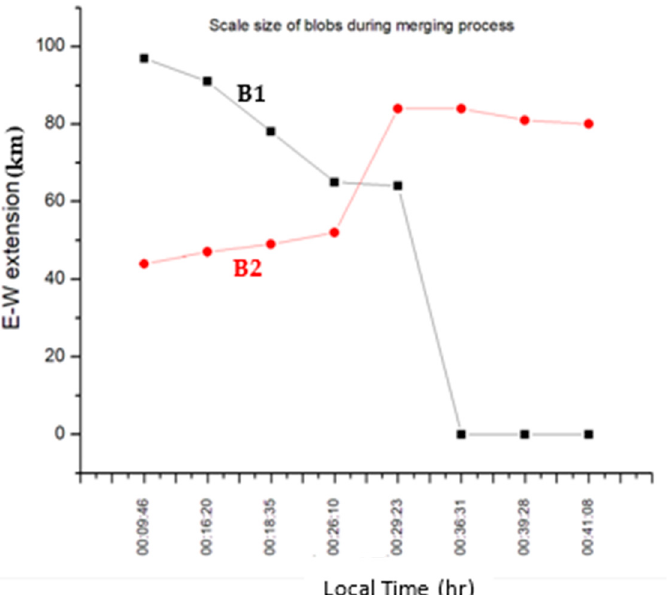
Figure 6. East–West scale-size of the blobs during the merging process on 26 October 2019, at ZF-2. B1 and B2 (B denotes blob) are studied to observe their E-W scale-size variation during merging.